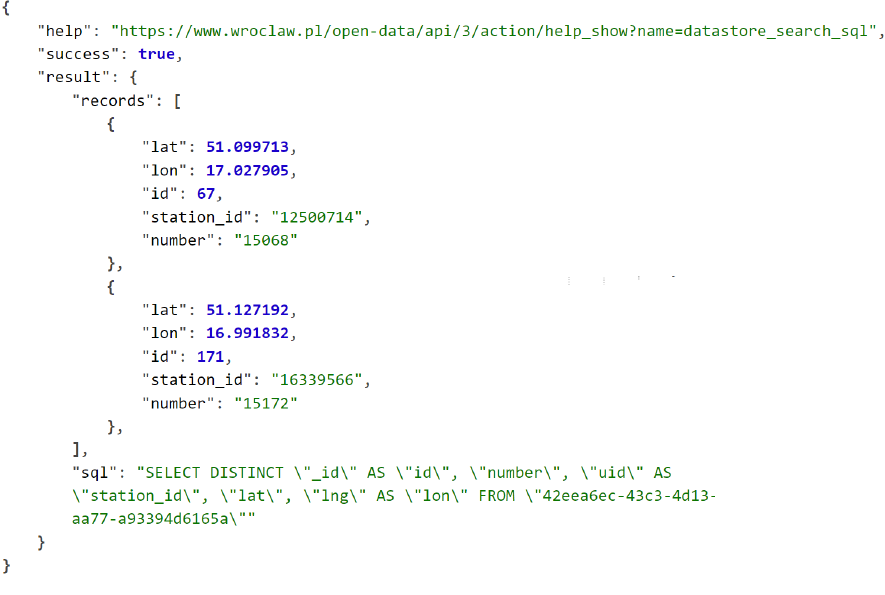
Figure 4. Server-side filtered and formatted Wrocław City Bike [85] on 16 October